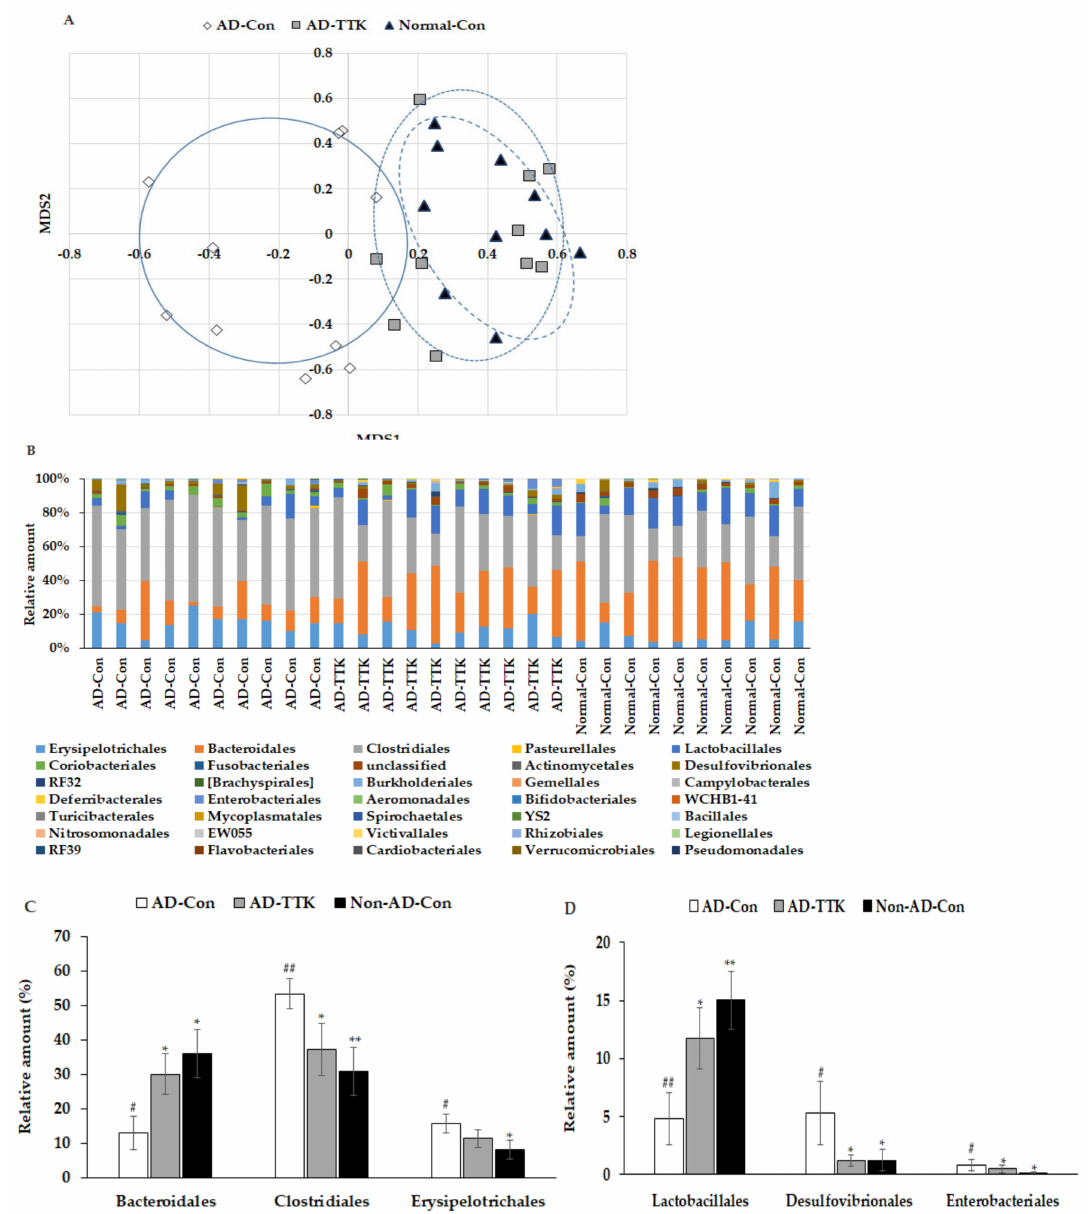
Figure 6. Profiles of gut microbiomes. At the end of the experiment, feces were collected from the cecum, and the bacterial DNA was analyzed using the next generation sequencing method. ( A ) Principal coordinate analysis (PCoA) of fecal bacteria. ( B ) Relative amount (%) of fecal bacteria in the [order] level. ( C ) Relative amount (%) of Bacteriodales , Clostridales , and Erysipelotrichales in the cecum. ( D ) Relative amount (%) of Lactobacillales , Desulfovibrionales , and Enterobacteriales in the cecum. AD-Con fed 45% fat diet with 0.5% dextrin in AD rats infused intra-CA1 infusion of amyloid- β (25–35), AD-TTK fed 45% fat diet with 0.5% water extract of Tetragonia tetragonioides (TTK) in AD rats, and Normal-Con fed 45% fat diet with 0.5% dextrin in non-AD rats infused intra-CA1 infusion of amyloid- β (35–25). Each value represents the mean ± SD of five mice in each group. # Significantly di ff erent among the groups in one-way ANOVA at p < 0.05 and ## p < 0.01. * Significantly di ff erent from AD-Con at p < 0.05, ** p < 0.01, and *** p < 0.001 in the Tukey test. † Significantly di ff erent from the Normal-Con at p < 0.05 in the Tukey